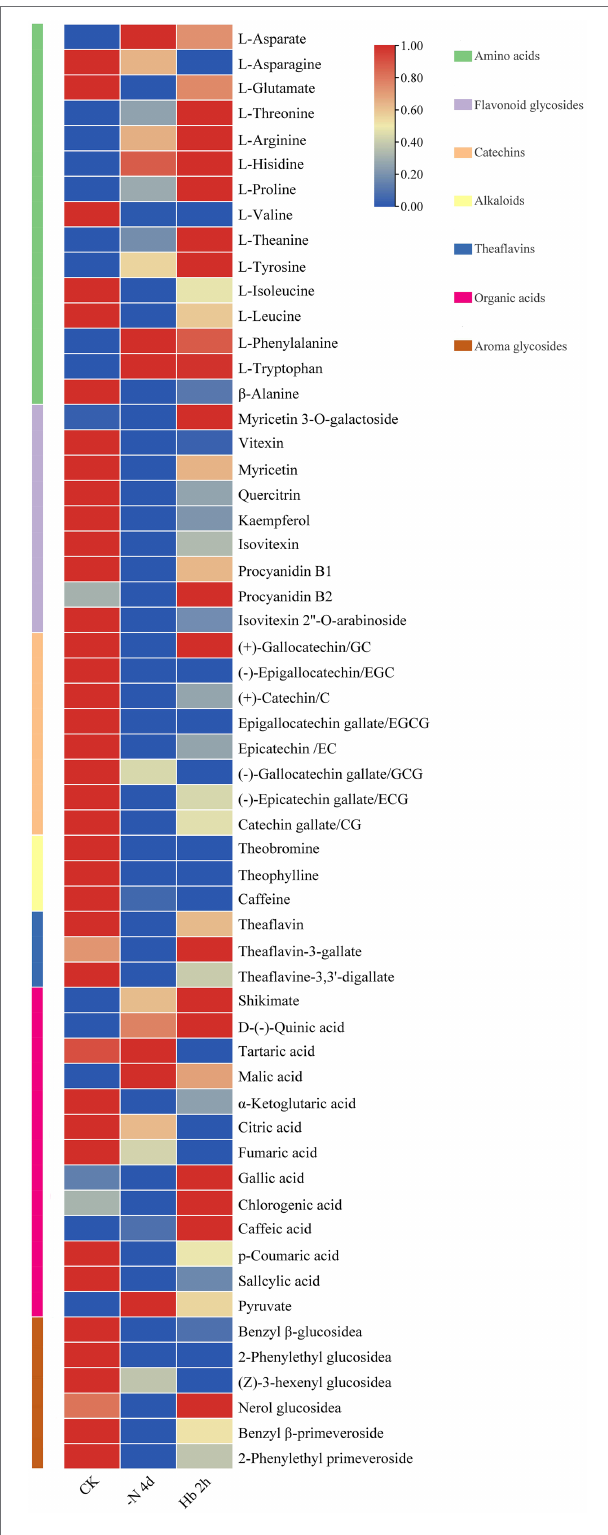
FIGURE 1 | Overall changes of metabolites in C. sinensis roots during nitrogen deprivation and resupply. The contents were analyzed with row standardization, with red for higher content and blue for lower